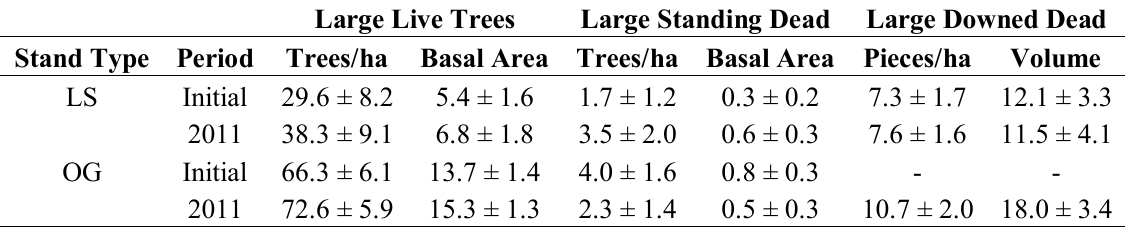
Table 2. Structural legacies, including density and basal area (m 2 /ha), large live and standing dead trees (≥40 cm DBH), as well as density and volume (m 3 /ha) of large downed dead wood (≥40 cm midpoint diameter), in late-successional (LS) and old-growth (OG) stands. Results are shown as mean ± 1 standard